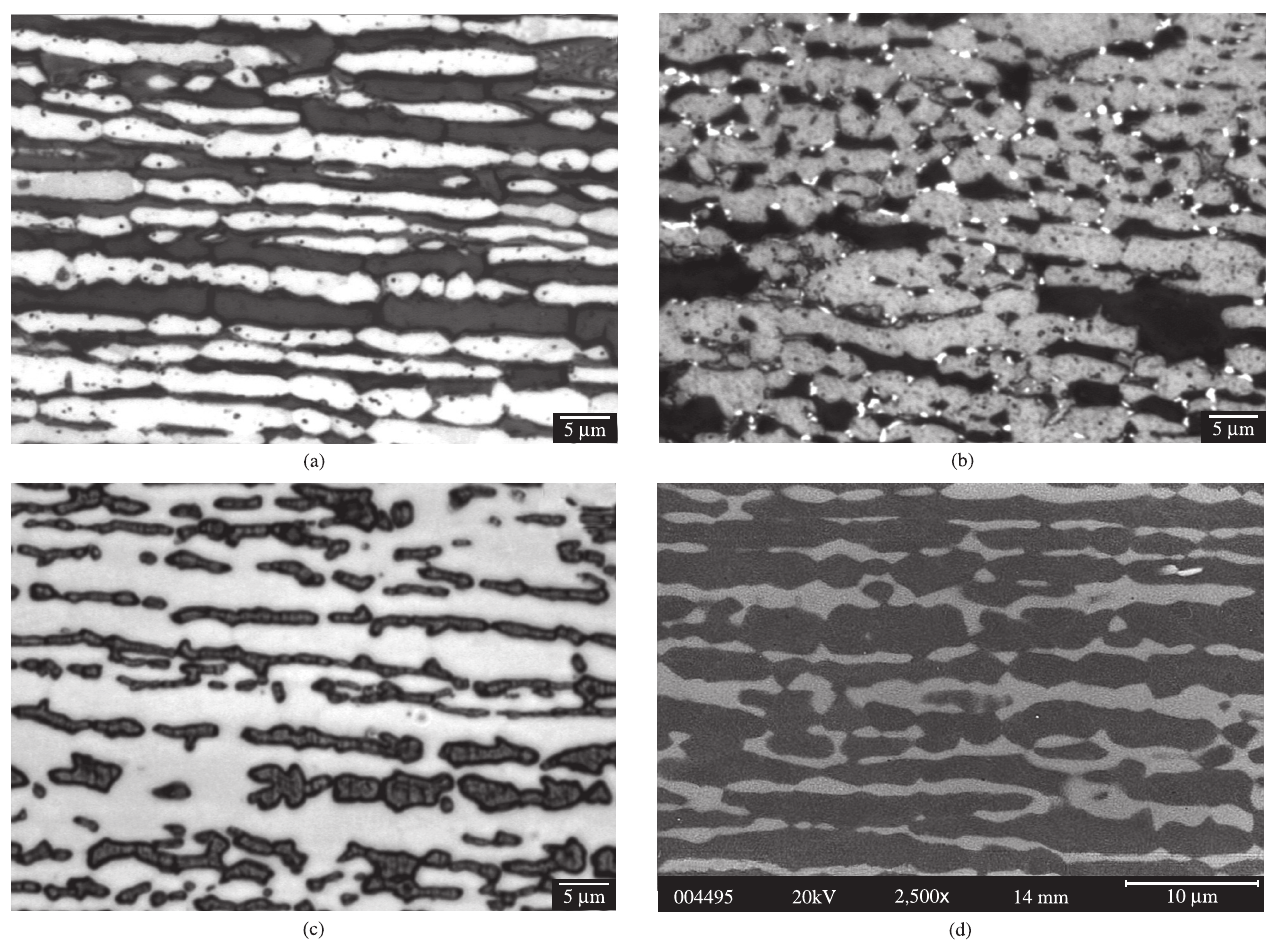
Figure 1. Typical microstructures found in the UNS S31803 DSS studied: a) solution-treated, showing ferrite (dark) and austenite; b) aged 10 minutes at 850 °C, showing ferrite (dark), austenite (gray) and sigma; c) aged 1 hour at 850 °C, sigma selectively etched; d) aged 100 hours at 850 °C, showing austenite (dark) and sigma. a) and b) are optical micrographs after modified Behara etching; c) is optical micrograph after KOH electrolytic etching; d) is BEI.